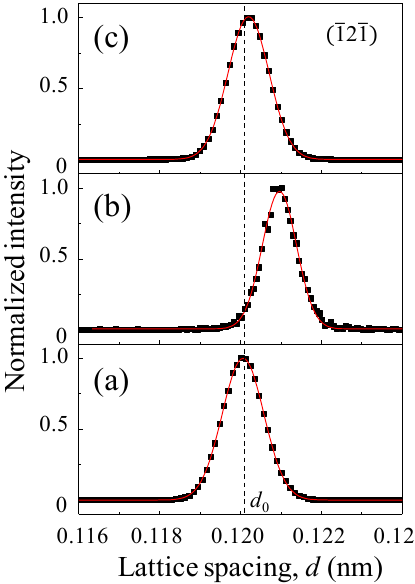
Figure 6. Lattice spacing ( d ) of the (121) plane as a function of applied strain ( a ) 0% (before loading); ( b ) 8% (under a load); and ( c ) 0% (unloaded). For comparison, the initial value at d 0 , the state before deformation, is indicated by the vertical dotted line. The d value was determined from a peak position of Gaussian fit (red lines).